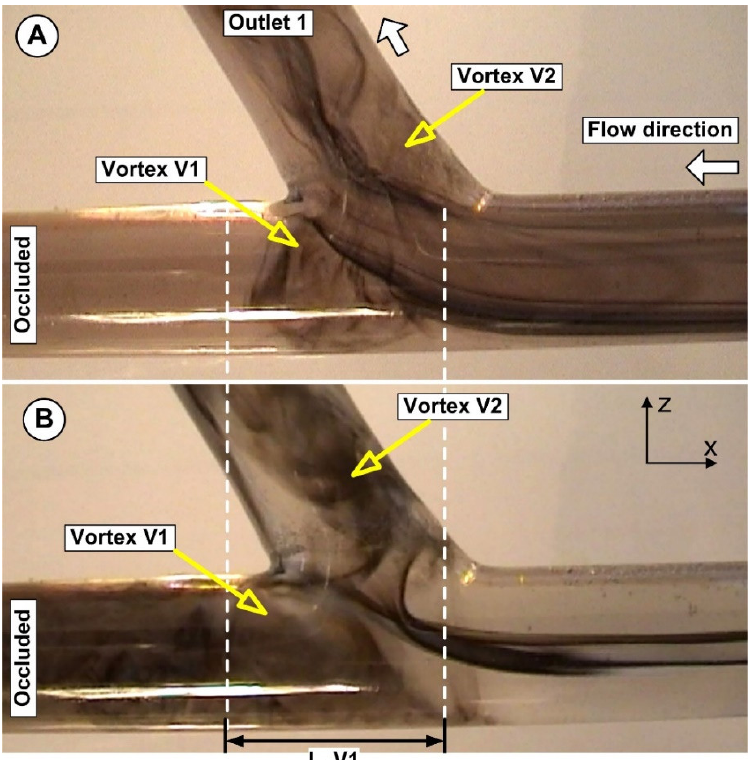
Figure 13. Flow field evolution in the artery bifurcation. ( A ) For a flow rate of Q1 = 362 mL/min and ( B ) for a flow rate of Q2 = 754 mL/min. The bifurcation induces the generation of two recirculation areas, one in the main artery (Vortex V1) and the other in the side branch (Vortex V2). The shape and extension of both vortices are directly related to the flow rate and the bifurcation angle.